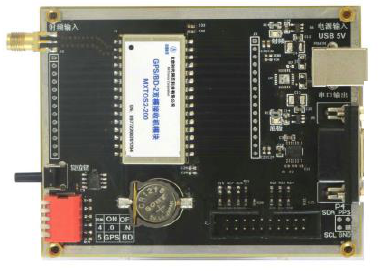
Figure 2: BDS/GPS dual-mode compatible thumb receiver